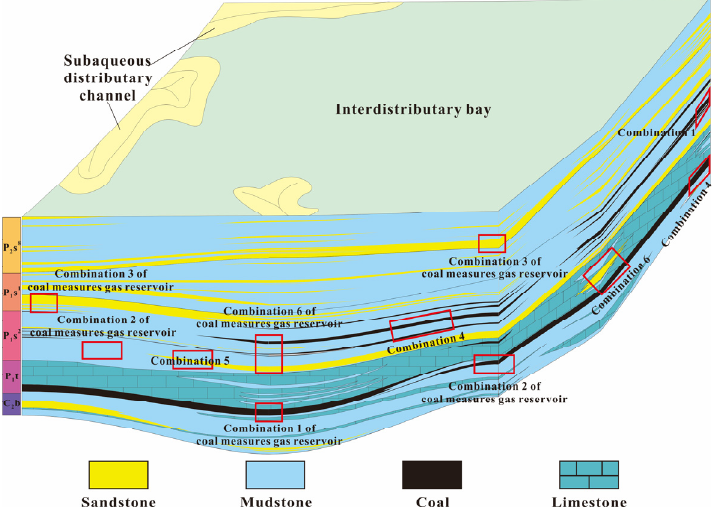
Figure 10. Comprehensive model of coal measure gas symbiotic accumulation in the Daning–Jixian Block .